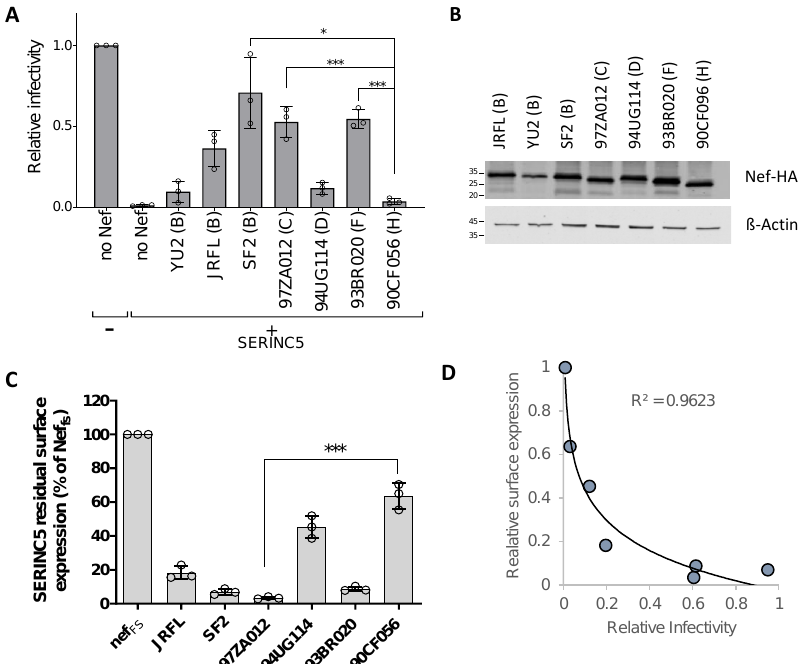
Figure 1. The ability of Nef to counteract SERINC5 is variable across the different viral isolates. ( A , B ) Nef proteins from isolates derived from different genetic subtypes have a variable ability to promote HIV-1 infectivity in the presence of SERINC5. ( A ) Infectivity of HIV-1 limited to a single cycle of replication produced in the presence of SERINC5 and the indicated nef alleles was determined on TZM-bl-ZsGreen indicator cells after normalization by RT-activity. Bar graphs represent the mean infectivity relative to the infectivity in the absence of SERINC5. Error bars represent s.d. from three biological replicates, unpaired two-tailed t -test, * p < 0.05, *** p < 0.001 ( B ) Detection of HA-tagged Nef proteins expressed in trans in producer cells from ( A ) by western blot. The letters in parentheses indicate the genetic subtype of the viral isolate. ( C , D ) The ability of Nef proteins to counteract the inhibition of infectivity by SERINC5 correlates with their ability to downregulate SERINC5 from the cell surface. ( C ) Residual SERINC5-iFLAG cell surface levels in cells co-transfected with the indicated nef alleles expressed upstream of an IRES2-eGFP cassette to allow for the exclusive gating of Nef-expressing cells. Nef Fs stands for Nef-frameshift, a control plasmid with the Nef ORF disrupted as explained in Materials and Methods. The residual SERINC5 surface expression was measured as median fluorescence intensity, and values are expressed as a percentage of the Nef Fs control. Error bars represent s.d. from three biological replicates, unpaired two-tailed t -test, *** p < 0.001 (Graphpad). ( D ) Dot plots correlating the relative infectivity from ( A ) and the residual SERINC5 surface expression from ( C ), with a logarithmic regression curve